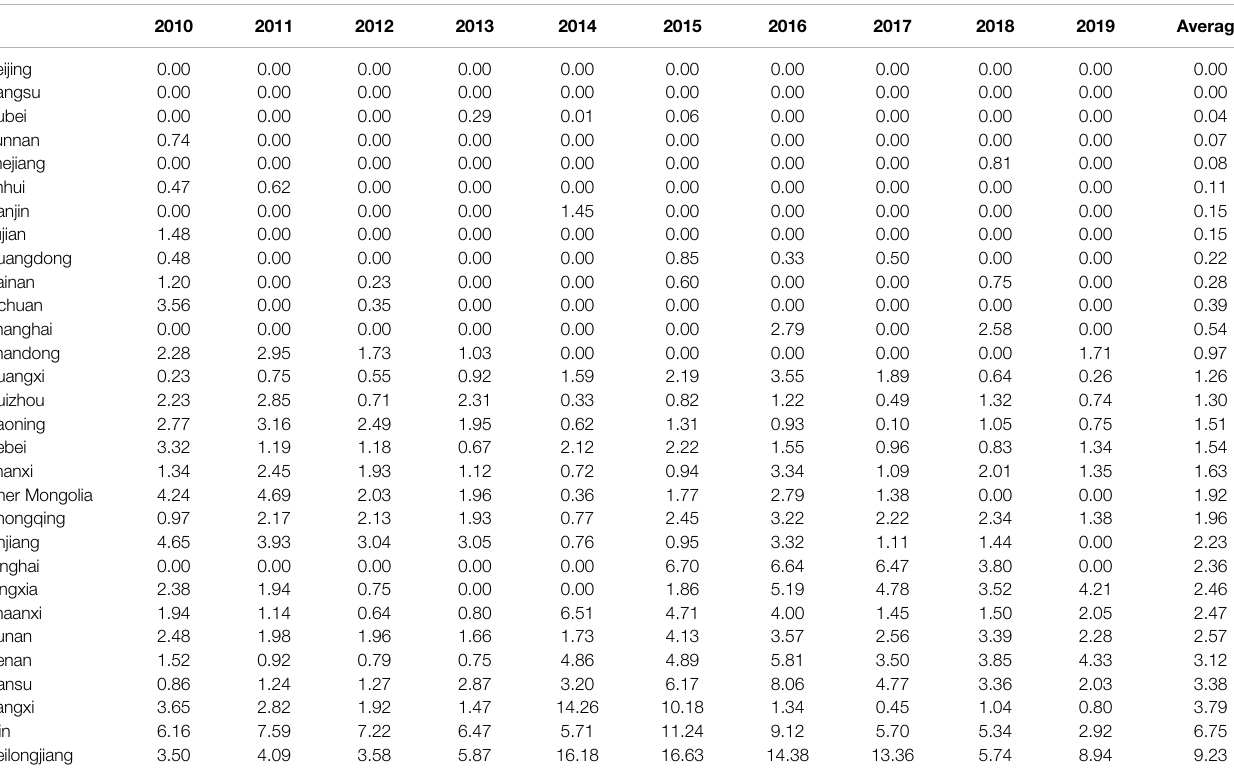
TABLE 3 | Gap ratios between the observations and the closest targets of the power sector